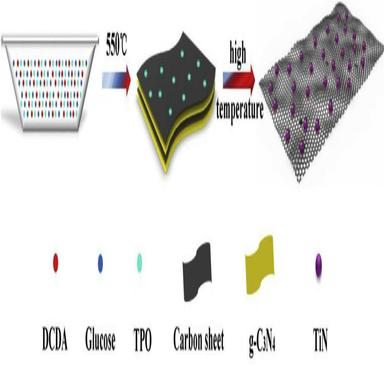
A schematic illustration of the synthetic process of TiN/NG nanocomposite.